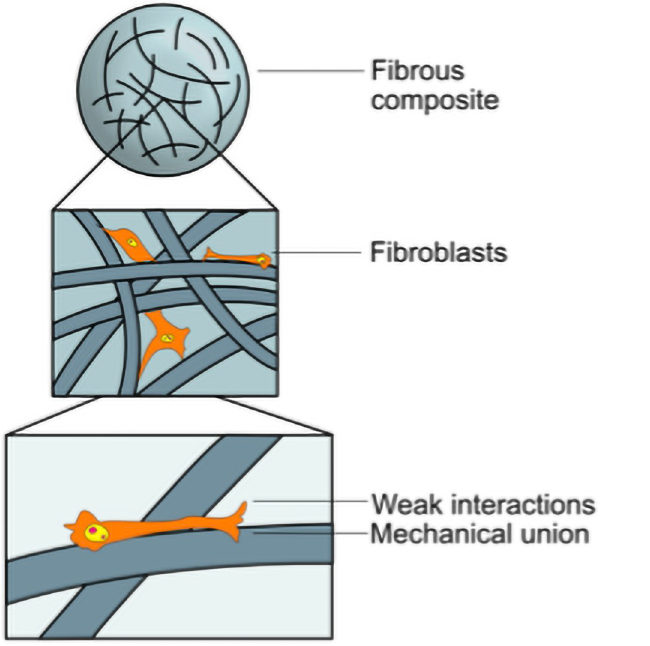
Fig 10. Schematic presentation of various fibers surfaces with cell